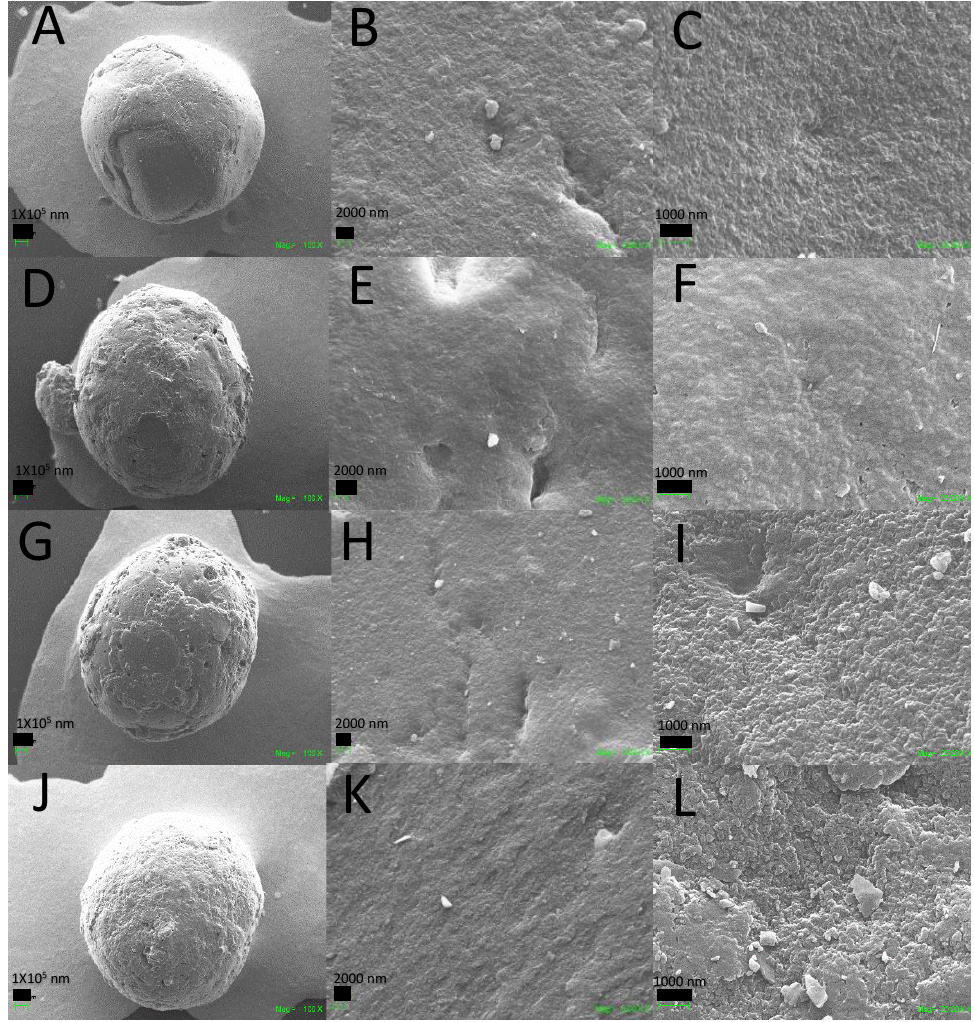
Figure 5. SEM images. Morphology of the beads: CS-GLA ( A ) at 100×, ( B ) at 1000×, ( C ) at 25,000×; CS-GO-GLA ( D ) at 100×, ( E ) at 1000×, ( F ) at 25000×; CS-TiO 2 -GLA ( G ) at 100×, ( H ) at 1000×, ( I ) at 25,000×; CS-TiO 2 -GO-GLA ( J ) at 100×, ( K ) at 1000×, ( L ) at 25,000×. The color of the CS-GLA beds ranged from yellow to light-red (Figure 6) due to the imine -C=N bonds formed between the -NH 2 and -CHO groups [56]. However, with the introduction of GO and TiO 2 in the beads, there was an obvious darkening effect [75].